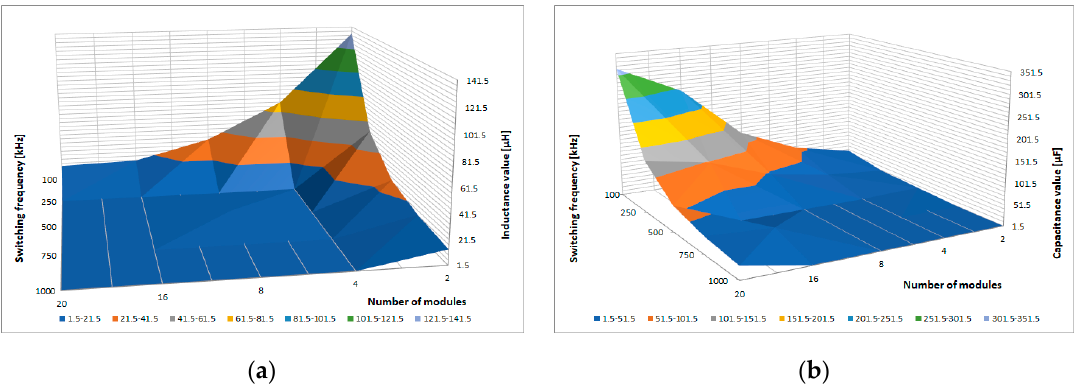
Figure 6. Three-dimensional dependency of the value of inductance L ( a ) and the value of capacitance C ( b ) on switching frequency and number of converter modules.